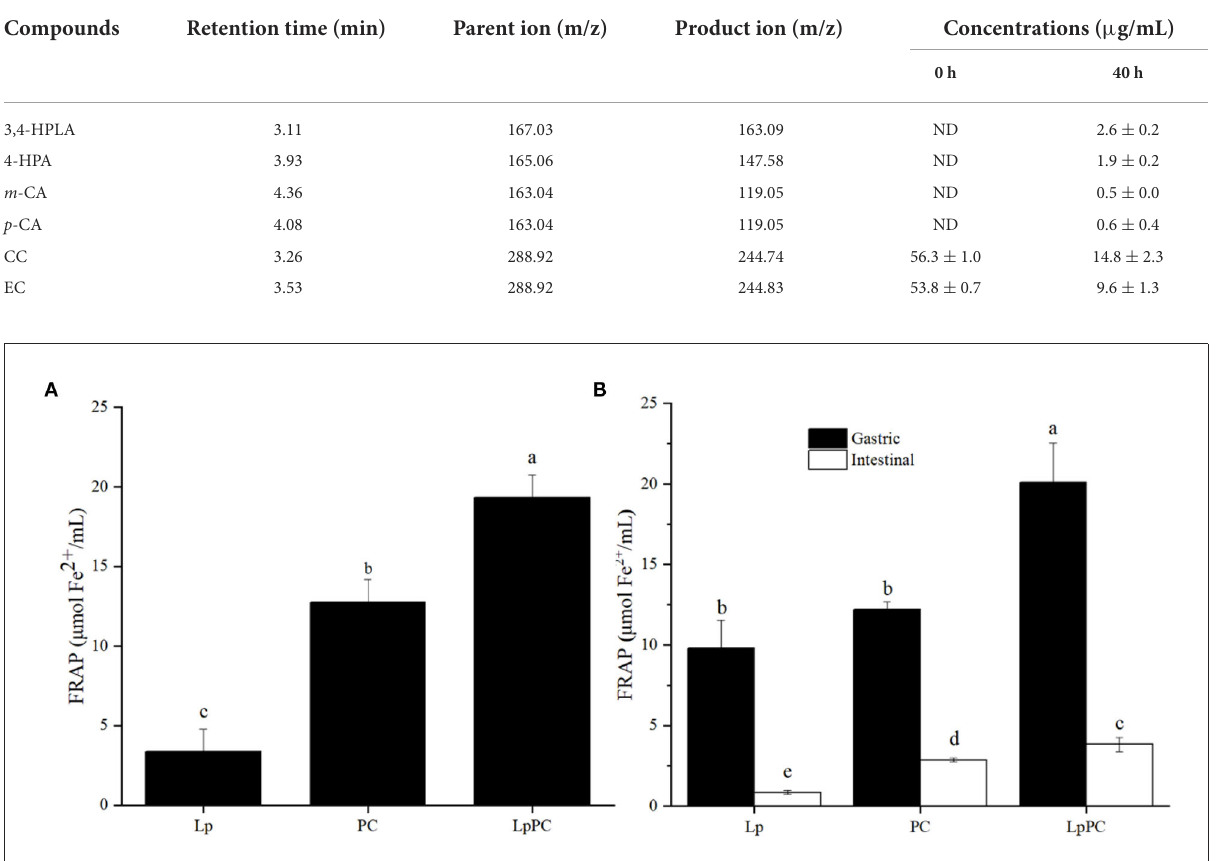
FIGURE4 Antioxidant activity of inoculated litchi pericarp oligomeric procyanidins (LPOPCs) in simulated food processing system (A) and gastrointestinal digestion system in vitro (B) .